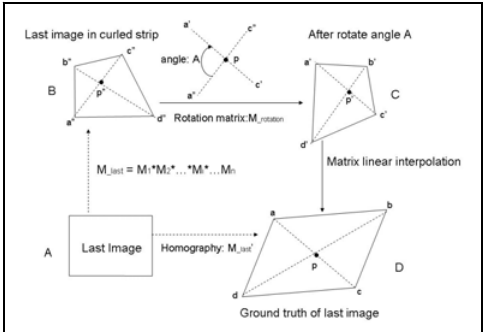
Figure 5. Image orientation is determined as the angle between one of the diagonals of image frame and one of axes regarding the intersection point of two diagonals as the origin. B is rotated to C, and C has generally similar orientation as D. Matrix linear interpolation is performed to evolve C to D, rather than from B to D